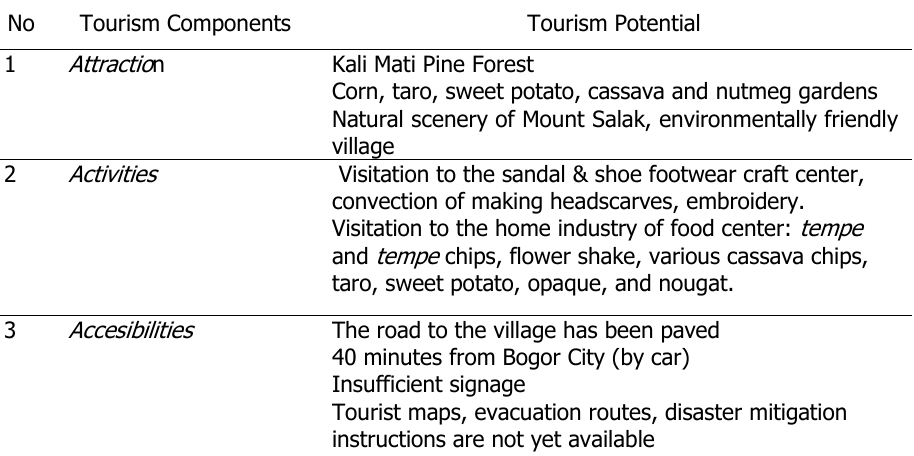
Table 2. Tourism Potential Analysis of Sukajadi